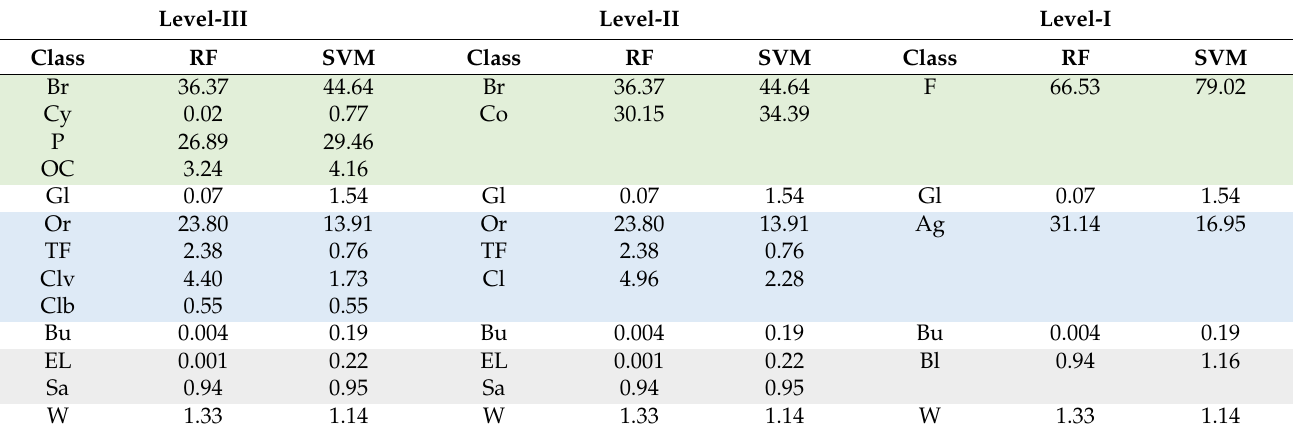
The colored box highlights the subclasses aggregated to a lower level of LULC